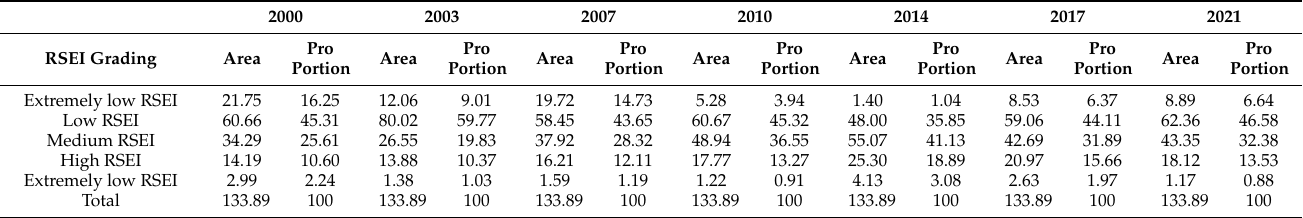
Table 5. Statistics of the areas (10 3 km 2 ) and proportions (%) of the RSEI classification levels in the Weihe River Basin during